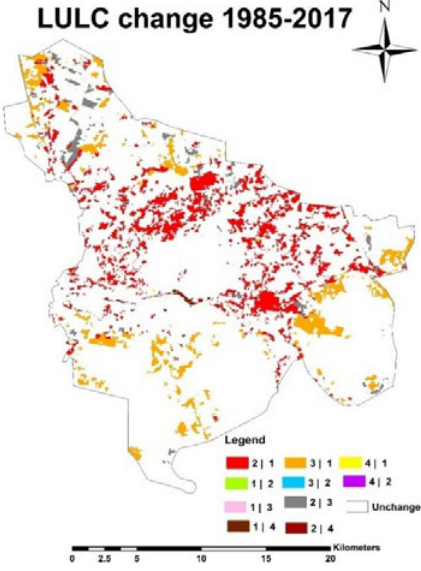
Fig. 3. LULC change from 1985 to 2017 in Isfahan